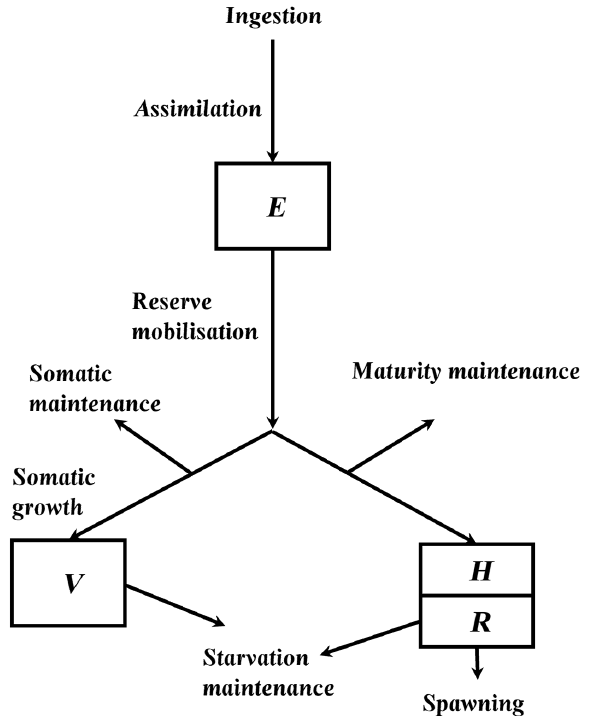
Fig. 3. Dynamic energy budget diagram illustrating ener- getic fluxes. E : energy reserves; V : structural volume; H : maturity level; R : reproductive